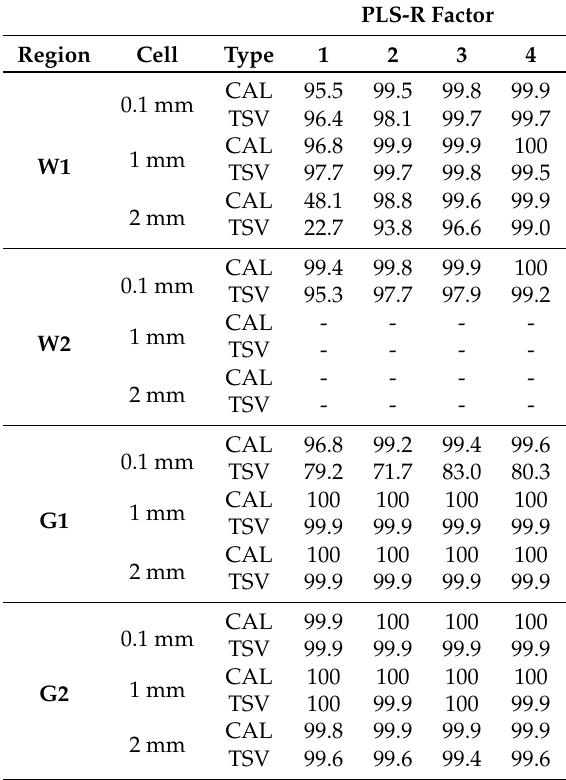
Table 3. Explained Y-variances for each spectral region and utilized cell. The type of validation (calibration or test set validation) and the number of PLS-R factors are specified. The values for the explained variances are given in